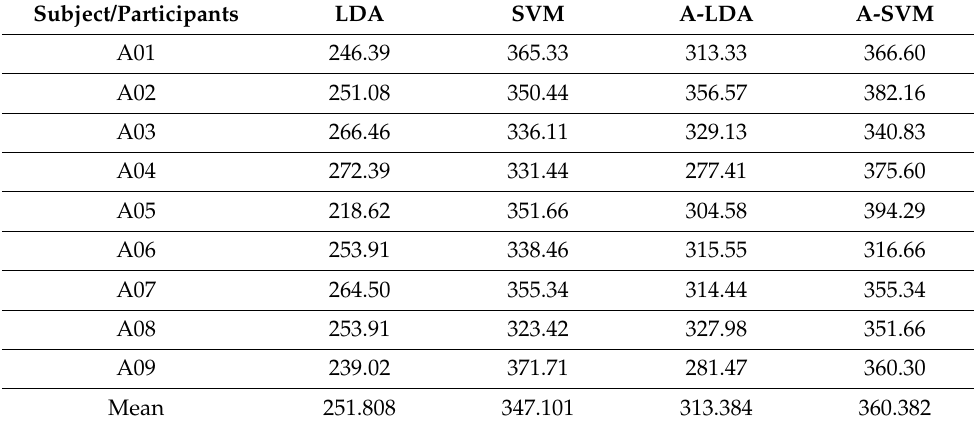
Table 4. Results of LDA, SVM, A-LDA, and A-SVM in terms of ITR (bits/min) on Motor Imagery